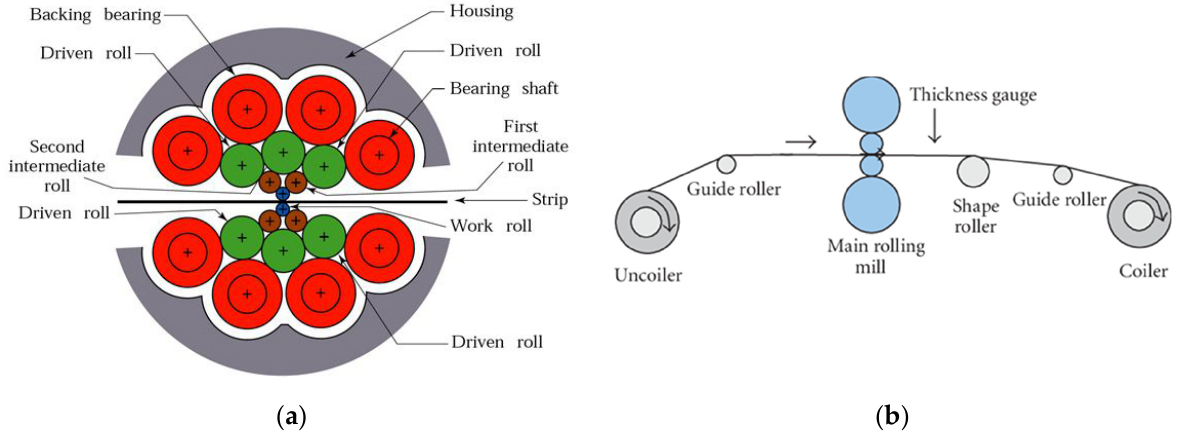
Figure 1. ( a ) Layout of the Sendzimir cluster mill; ( b ) layout of the 4-high hot rolling mill.